Question: Express in one sentence what the figure is showing.
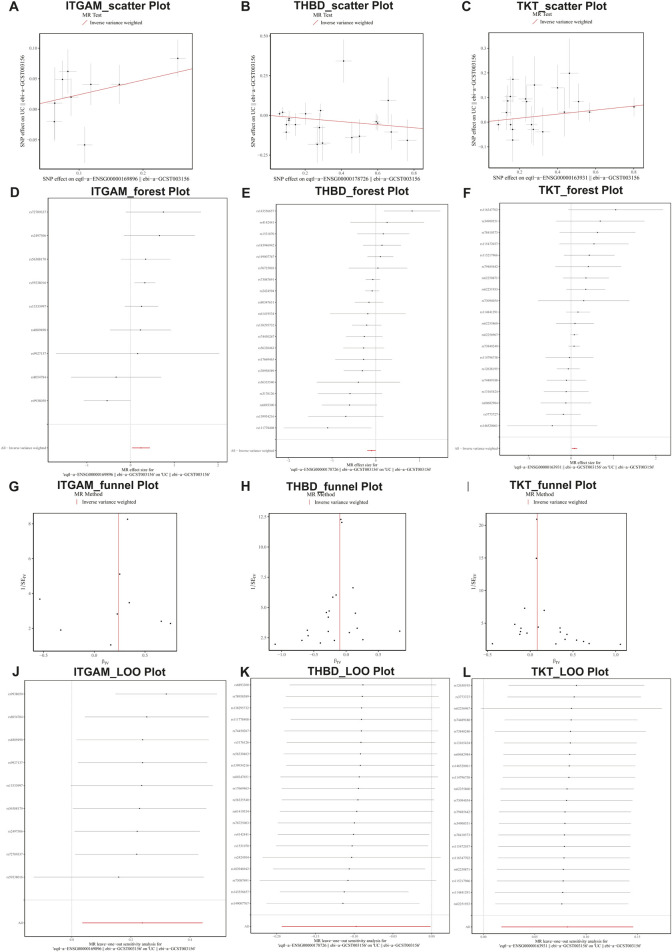
Answer: Three potential biomarkers with genetic correlations to SLE were identified through Mendelian randomization (MR) analysis (A–C) Scatter plots of the inverse-variance weighted (IVW) method demonstrated the genetic correlations of THBD, ITGAM, and TKT with SLE, where the fold and intercepts of the vertical coordinates were near zero, indicating minimal confounding effects. (D–F) Forest plots displayed the effect size of the three genes: ITGAM (OR = 1.270, 95% CI = 1.036–1.557, p = 0.021) and TKT (OR = 1.085, 95% CI = 1.018–1.157, p = 0.013) as risk factors, and THBD (OR = 0.907, 95% CI = 0.824–0.999, p = 0.047) as a protective factor for SLE. (G–I) The uniform distribution of the genetic loci on both sides of the midline aligned with Mendel’s second law, further supporting the robustness of the results. (J–L) Leave-one-out (LOO) sensitivity analysis verified the robustness and reliability of the MR analysis, showing that the genetic correlations of THBD, ITGAM, and TKT with SLE remained consistent.